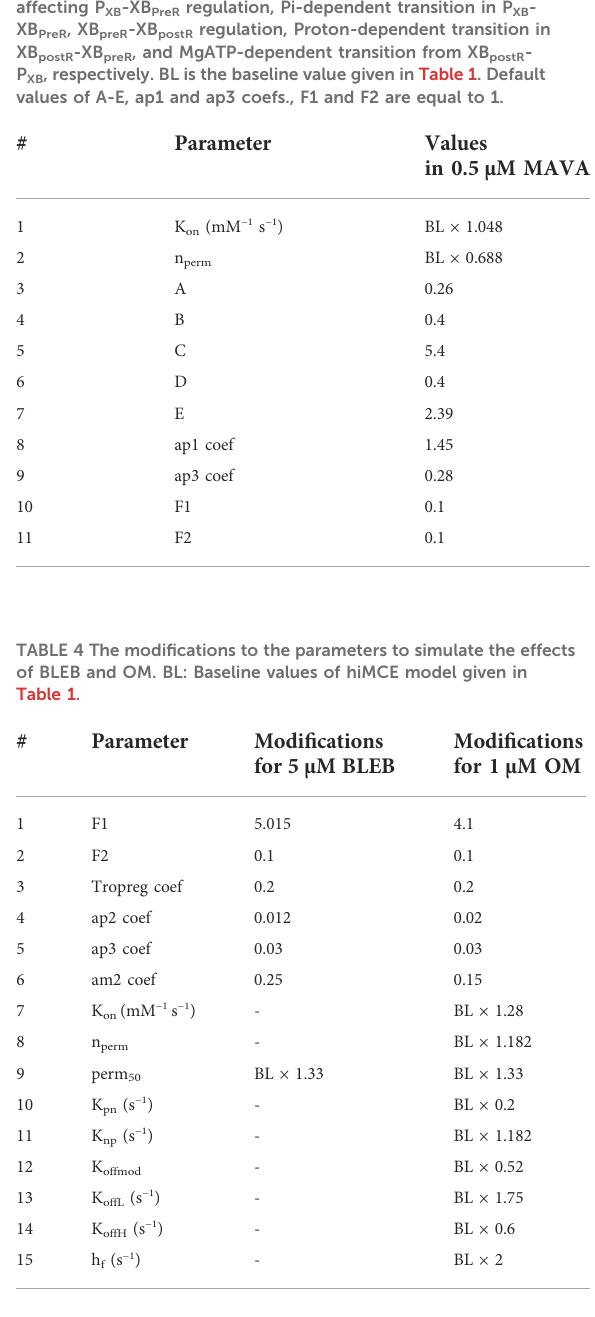
TABLE 3 Modi fi cations to the model parameters tosimulate the effect of Mavacamten. A, B, C, D, and E are coef fi cients in Eqs 15 – 19